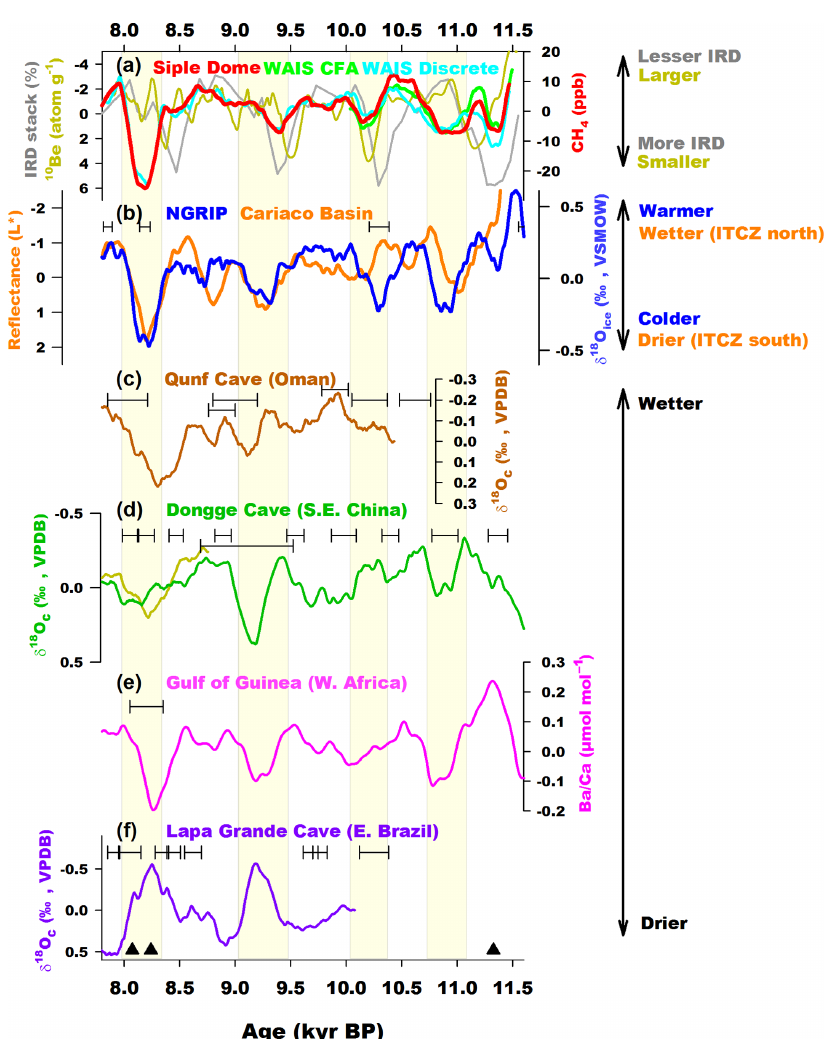
Figure 2. Millennial-scale climate variability. All proxies presented here were smoothed by 250-year running average and detrended by high- pass filter with 1/1800-year window. (a) Siple Dome CH 4 (red, this study), Greenland 10 Be (dark yellow; Finkel and Nishizumii, 1997), North Atlantic IRD stack (grey, Bond et al., 2001). Also shown are WAIS Divide CH 4 data by discrete (cyan, denoted “WAIS Discrete”; WAIS Divide project members, 2015) and continuous (yellow green, denoted “WAIS CFA”; Rhodes et al., 2015) technique. (b) NGRIP stable water isotope ratio (blue; Rasmussen et al., 2006) and Cariaco Basin reflectance (orange, Deplazes et al., 2013). (c) Qunf Cave speleothem oxygen isotope (Fleitmann et al., 2007). (d) Dongge Cave speleothem oxygen isotope (green: Dykoski et al., 2005; dark yellow: Wang et al., 2005). (e) Gulf of Guinea planktonic Ba / Ca ratio (Weldeab et al., 2007). (f) Lapa Grande Cave speleothem oxygen isotope (purple; Strikis et al., 2011). Black solid triangles are age tie points used to adjust Siple Dome and WAIS Divide CH 4 data to GICC05